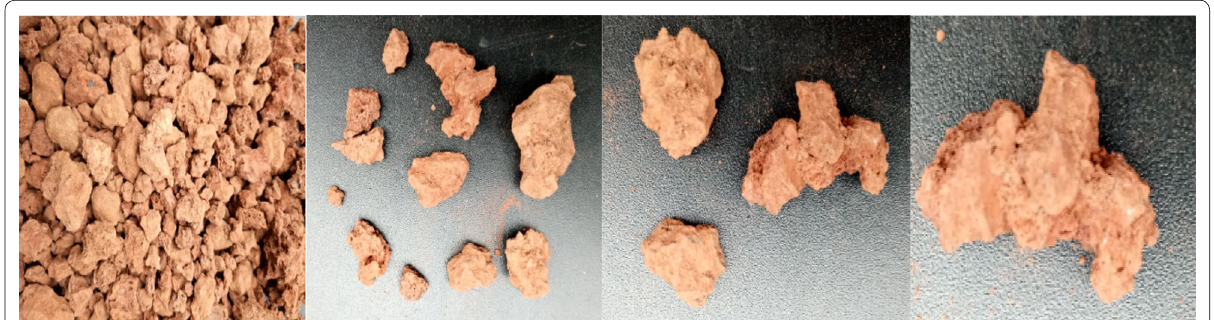
Fig. 2 Typical scoria: photograph Mekonnen Birhanie March/2016,